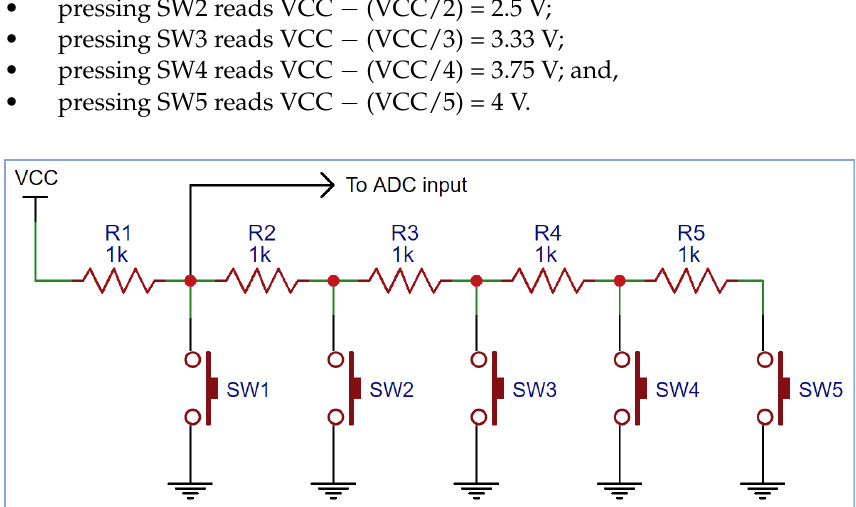
Figure 8. The schematic of several buttons using a circuit with variable resistance to be connected to a single pin of the microcontroller, which, in turn, connects to an analog-to-digital converter (ADC) to sense the voltage measured at the input and convert it to a digital